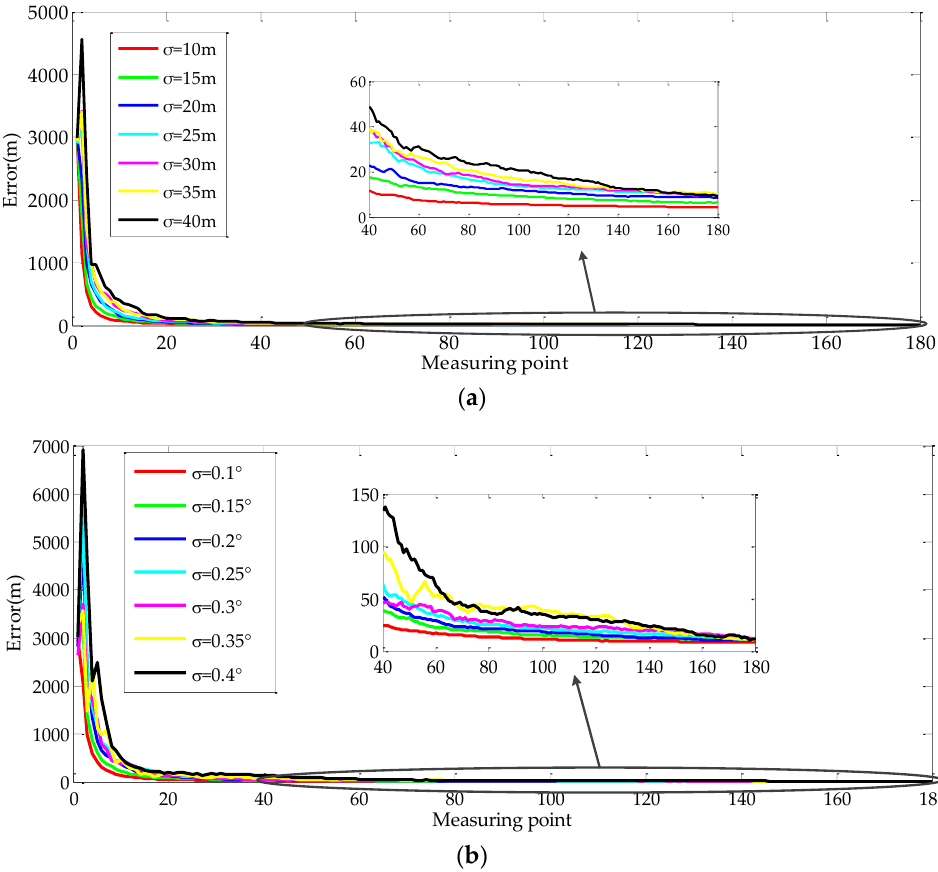
Figure 10. Influence of measurement variances on geo-location: ( a ) Geo-location error curves with dif-